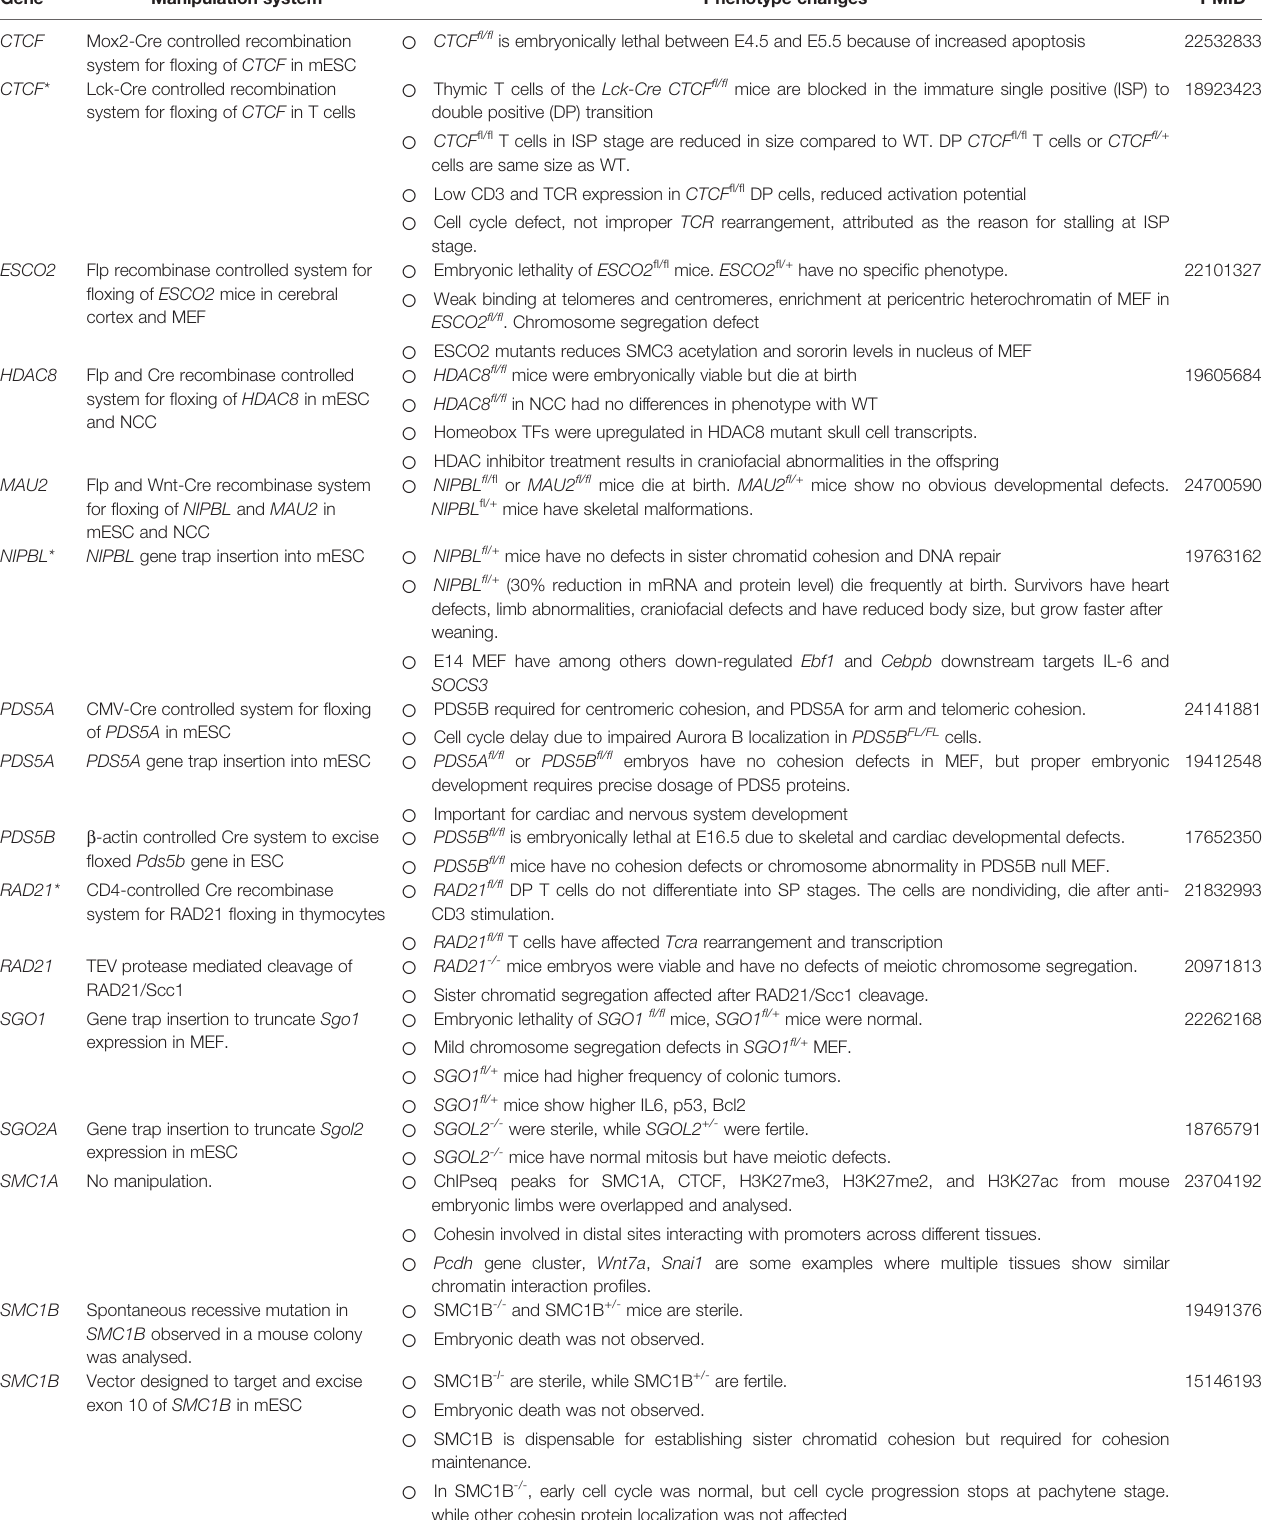
TABLE 2 | Manipulation of cohesin complex proteins in